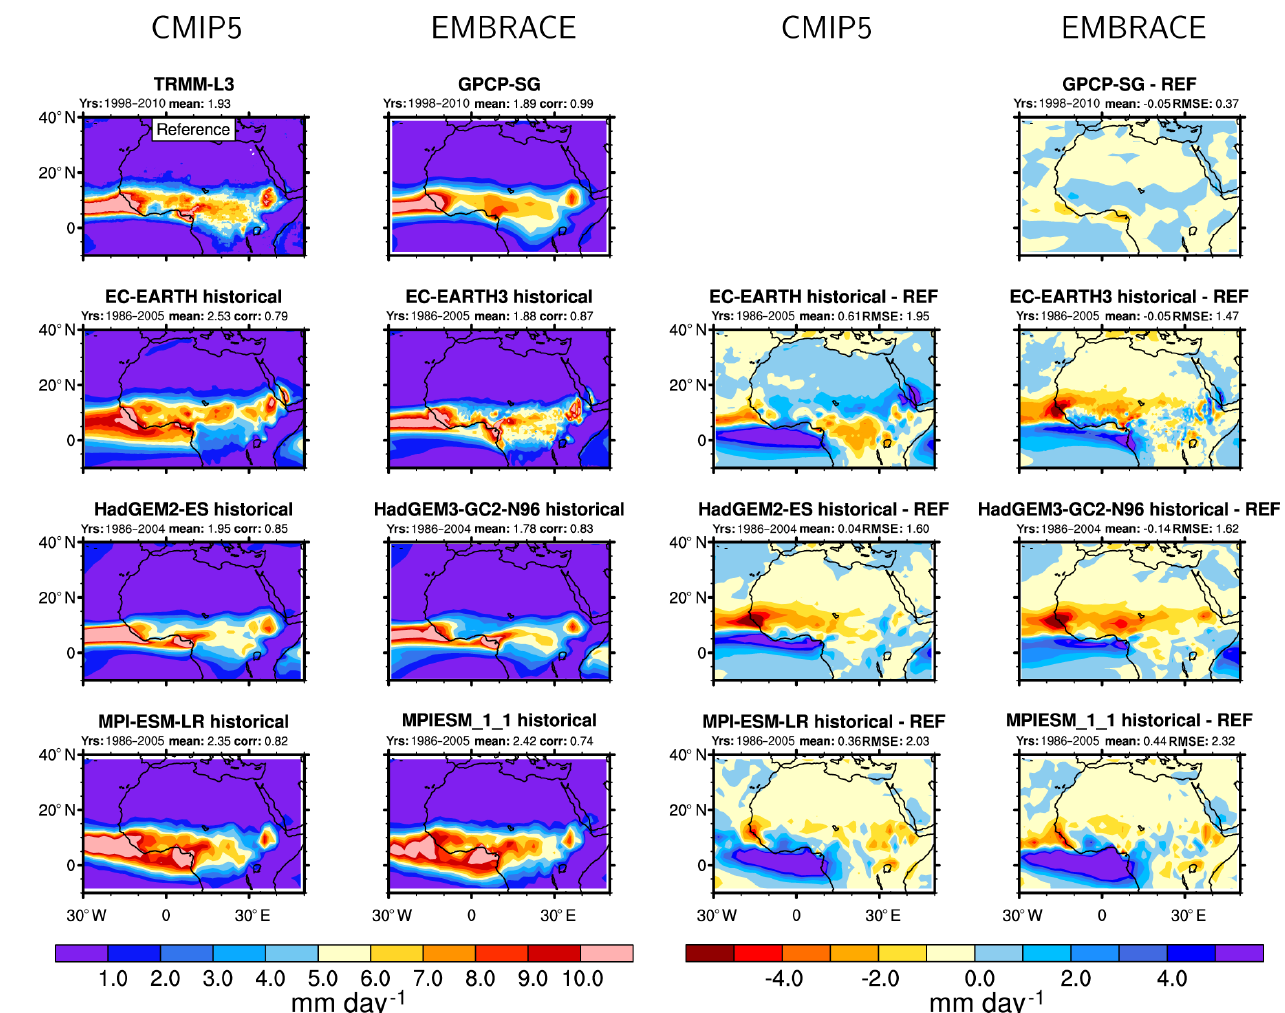
Figure 7. Leftmost two columns: seasonal mean precipitation for JJAS from observations (TRMM, GPCP) and the coupled simulations. The years used to calculate the averages shown are given above each panel (“yrs”). Rightmost two columns: differences relative to TRMM. Columns 1 and 3 show the original CMIP5 model versions, columns 2 and 4 the EMBRACE-updated models. The domain-averaged annual mean (“mean”), linear pattern correlation (“corr”; leftmost two columns), mean bias (“mean”), and root mean square error (RMSE; rightmost two columns) compared with TRMM are given above the individual